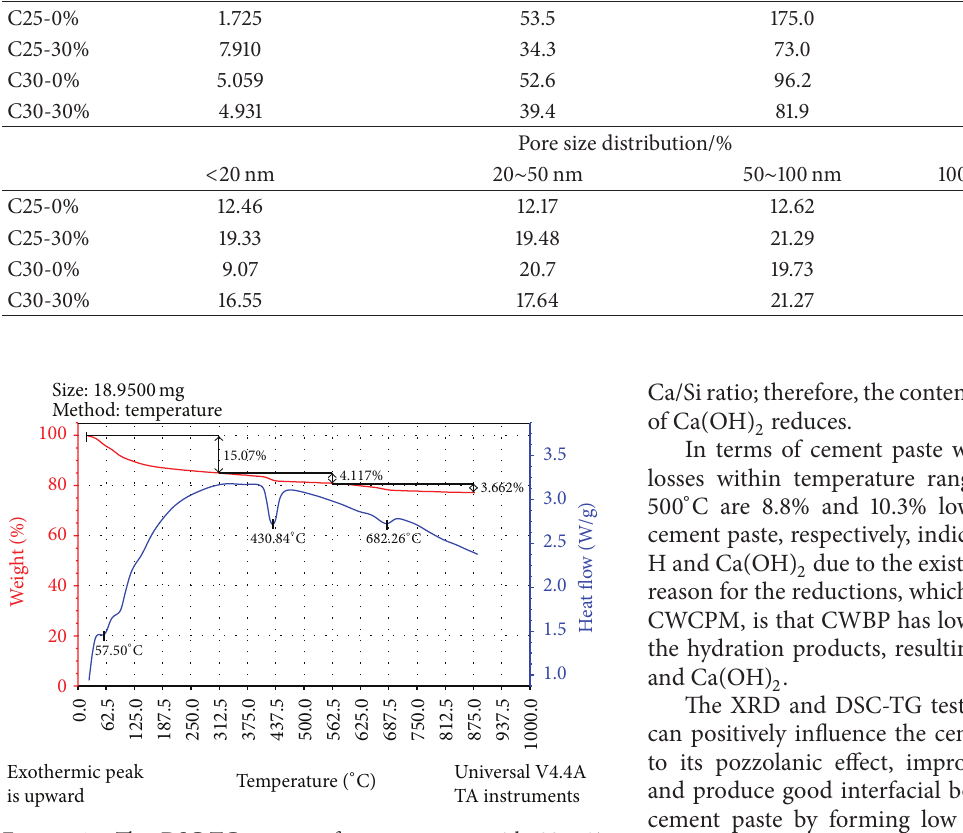
Figure 15: The DSC-TG curves of cement paste with 30wt%